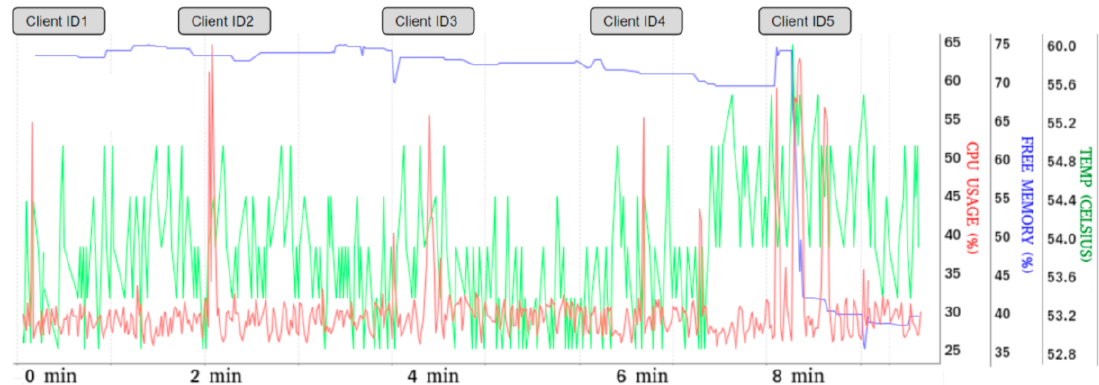
Figure 9. Control device operational data during the experiment with multiple user connections